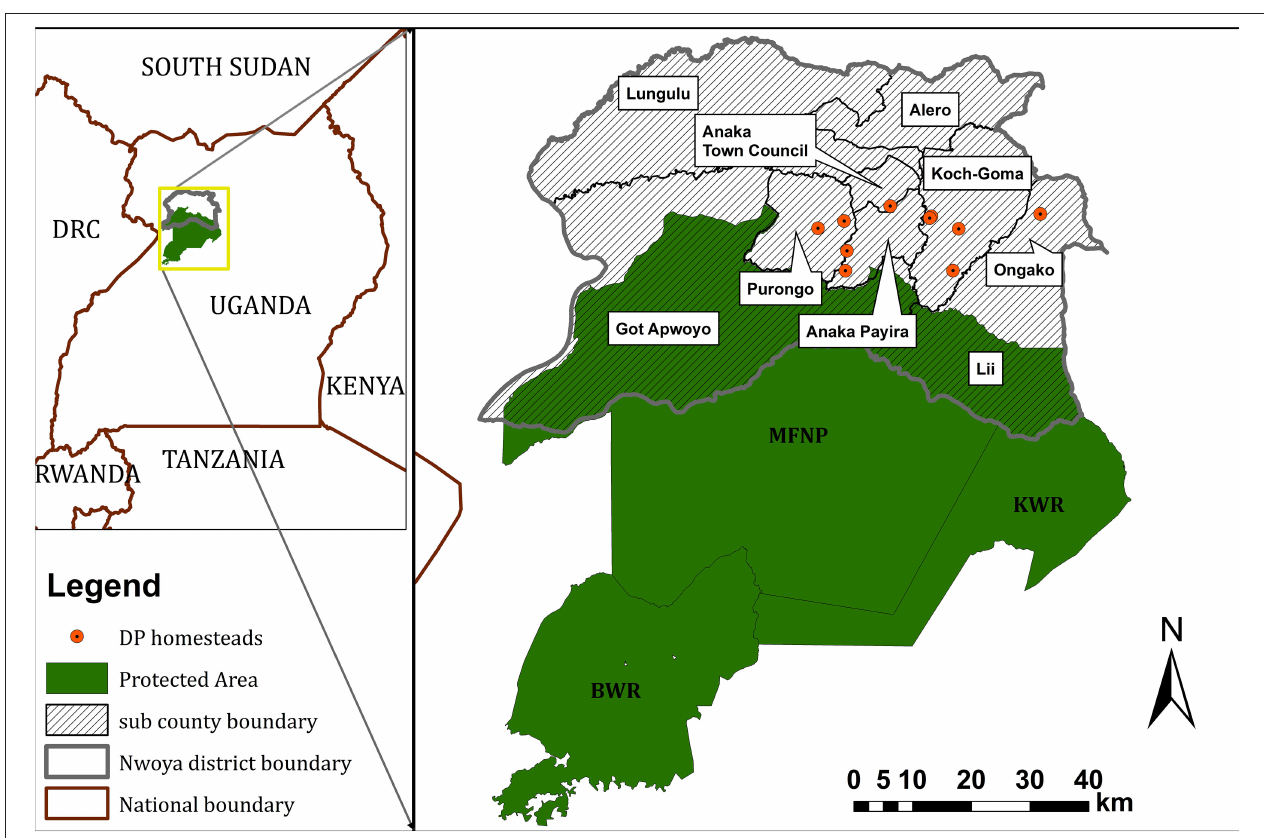
FIGURE 1 | Location of the study site showing the homesteads from which domestic pigs (DP) were collared within Nwoya district and the Murchison Falls Conservation area composed of Murchison Falls National Park (MFNP), Karuma Falls Wildlife Reserve (KFWR) and Bugungu Wildlife Reserve (BWR).